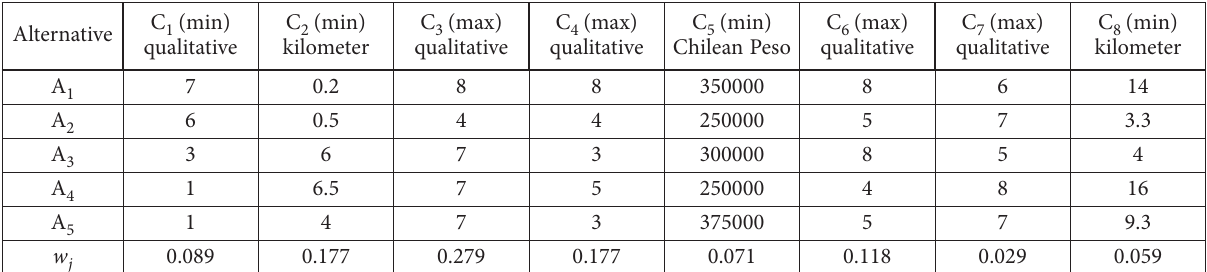
Table 8. The initial decision-making matrix for Scenario